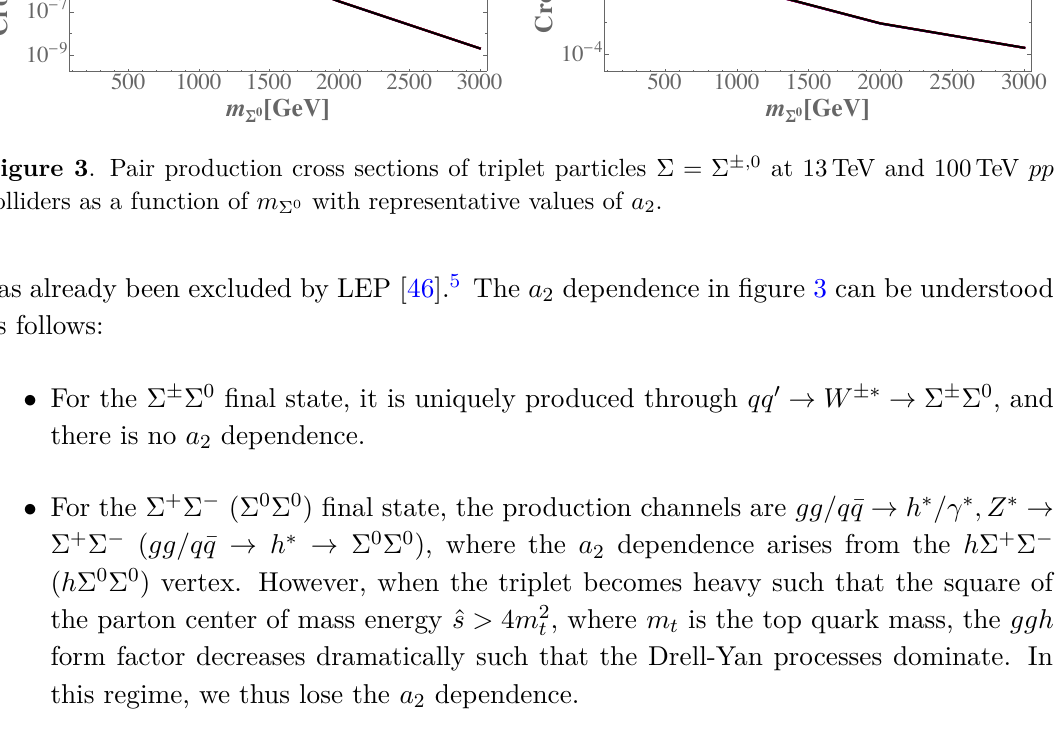
, 0 at 13 TeV and 100 TeV pp ±